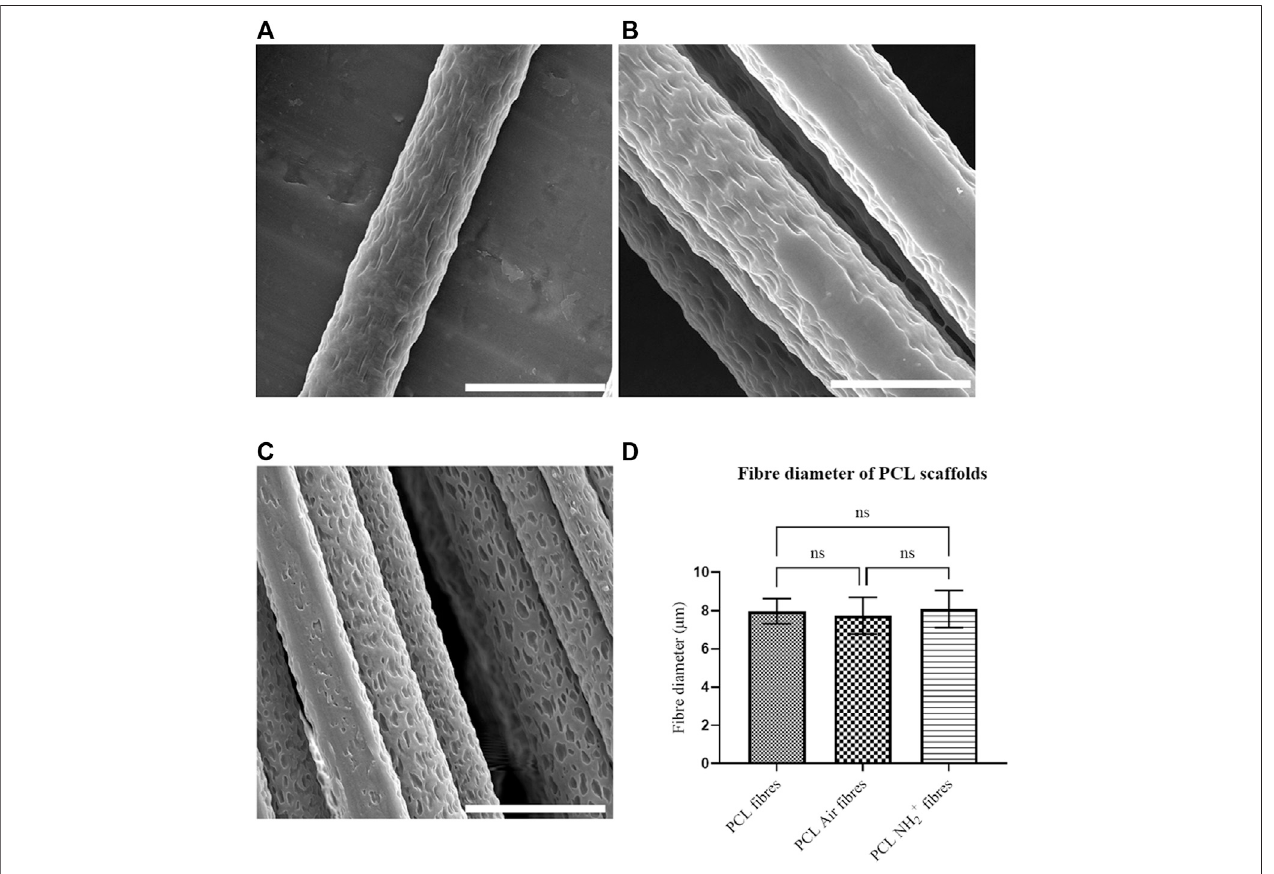
FIGURE 1 | PCL electrospun fi bres morphology. (A) PCL fi bre before plasma deposition; (B) PCL fi bre after air plasma deposition; (C) PCL fi bre after allylamine plasma deposition; (D) Bar chart showing fi bre diameter of PCL fi bres before and after plasma deposition, with no signi fi cant differences (One-way ANOVA). Scale bar (cid:2) 10